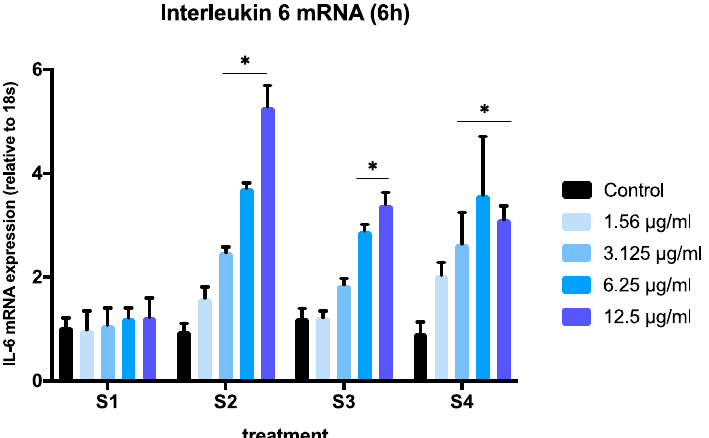
Figure 4. Expression of human interleukin-1 mRNA (IL1B) (relative to 18S expression) in BEAS-2B cell after exposure to soot preparations for 6 h. The graph summarizes data from three independent experiments ( n = 3 replicates per experiment), with results normalized to controls (exposed to methanol) and expressed as mean ± SEM. Two-way ANOVA interaction: p = 0.0109, F (12, 71) = 2.415; concentration effect: p < 0.0001, F (4, 71) = 30.51; soot type effect ( p < 0.0001, F (3, 71) = 15.48). * p < 0.05, different from control (Dunnett’s multiple comparison’s test). For a description of S1–S4, see Section 2.